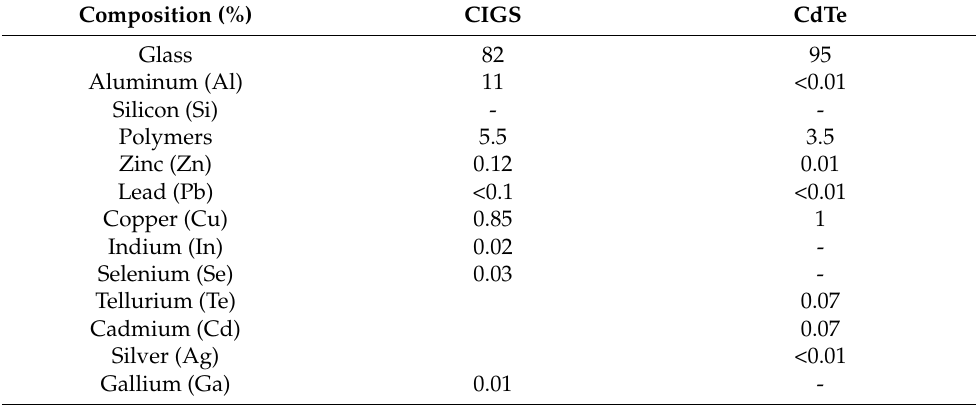
Table 4. Composition of thin-film PV